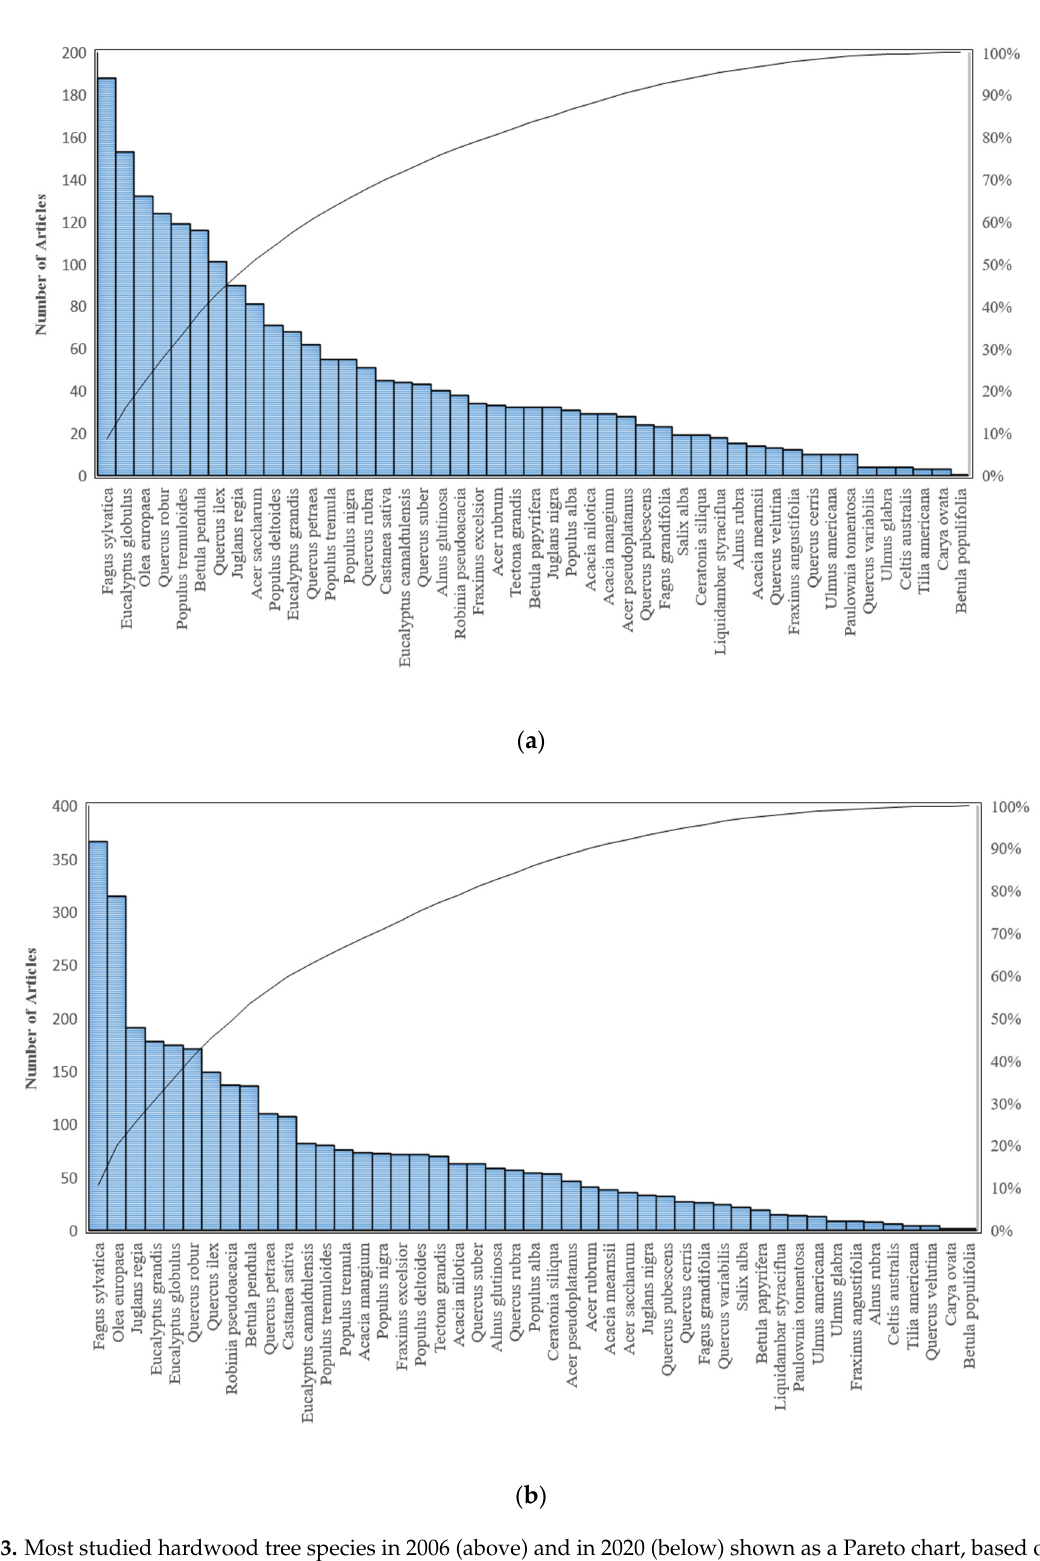
Figure 3. Most studied hardwood tree species in 2006 (above) and in 2020 (below) shown as a Pareto chart, based on Web of Science data.